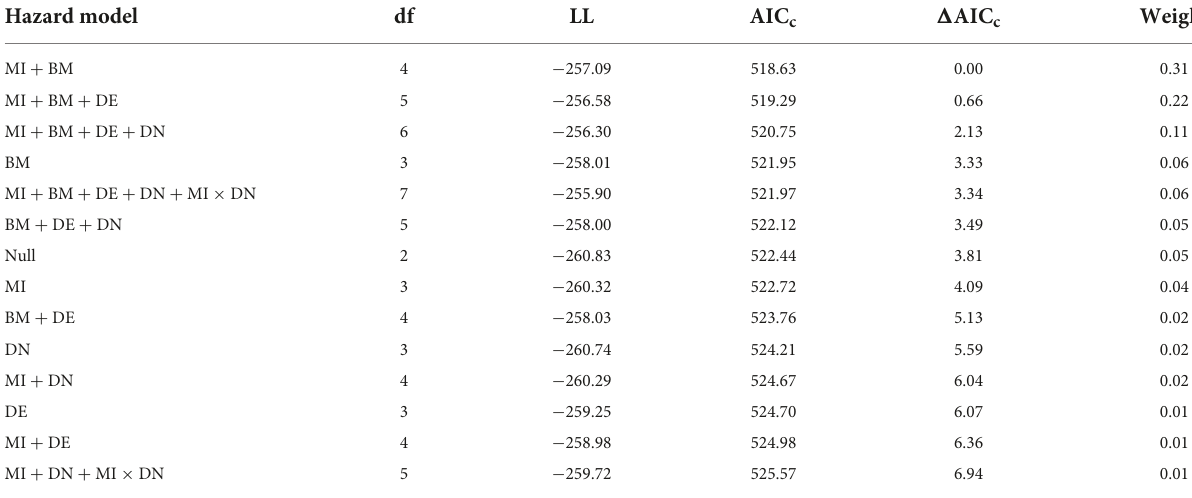
TABLE 3 Model selection criteria for individual-level models of hazards to survival of adult female caribou in the Central Arctic Herd, Alaska, 2003–2020. Hazard